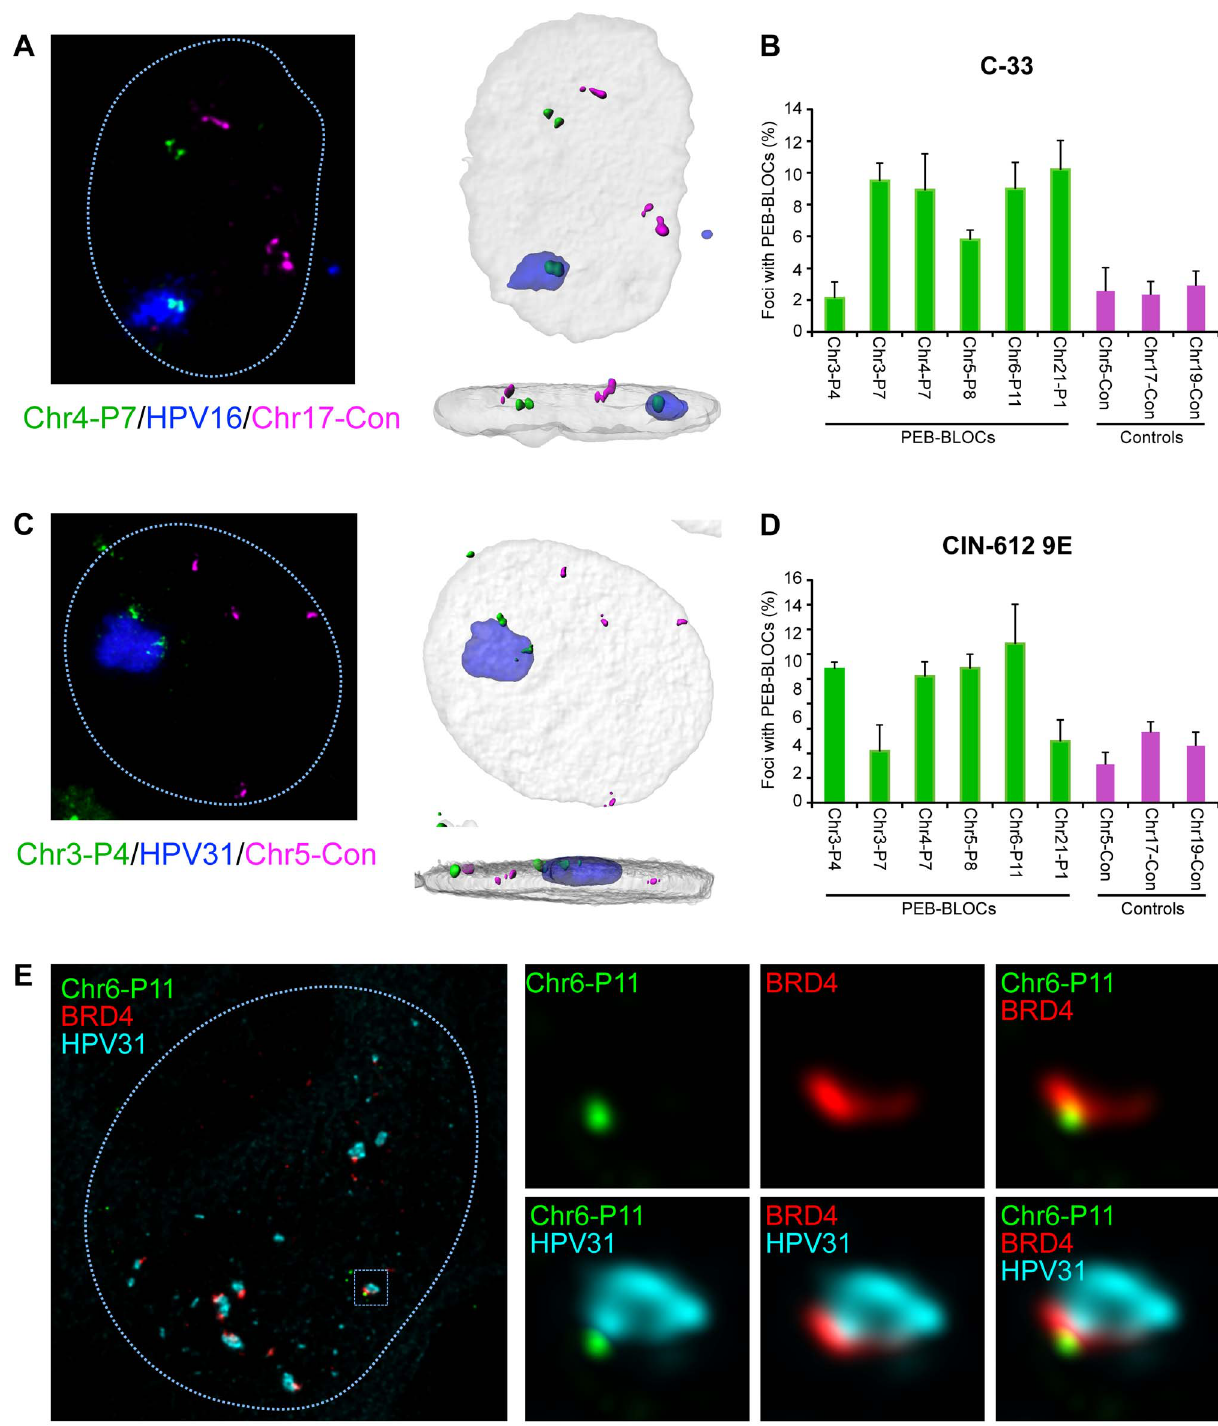
Figure 8. Papillomavirus replication factories are associated with PEB-BLOCs. A. C-33 cells containing replicating HPV16 genomes were analyzed by FISH. The representative image shown was probed with HPV16 DNA (blue), Chr4-P7 PEB-BLOC (107E21 BAC clone; green) and a control region (304M13; magenta). 3D image stacks were deconvolved using Huygens Essential software. High resolution surface renderings of all objects were generated by Bitplane Imaris software. B. PEB-BLOCs were probed in the cells described in A, using a combination of labeled BAC clones (124A13, 1079D6, 107E21, 126M10, 1062A20 corresponding to PEB-BLOCs Chr2-P6, Chr3-P7, Chr4-P7, Chr5-P8, Chr6-P11), control BAC clones (182E4, 304M13, 568L16 representing negative regions) and HPV16 DNA. Approximately 100 cells were analyzed for colocalization of HPV16, PEB-BLOCs or control regions. Average values and STDEV were calculated for three independent experiments. C. Differentiated CIN-612 9E cells were analyzed by FISH. The representative image shown was probed with HPV31 DNA (blue), Chr3-P4 PEB-BLOC (452E16 BAC clone; green) and control region (182E4; magenta). 3D image stacks were deconvolved using Huygens Essential software. High resolution surface renderings of all objects were generated by Bitplane Imaris software. D. PEB-BLOCs, HPV31, and negative regions were detected using BAC clones (452E16, 1079D6, 107E21, 126M10, 1062A20,